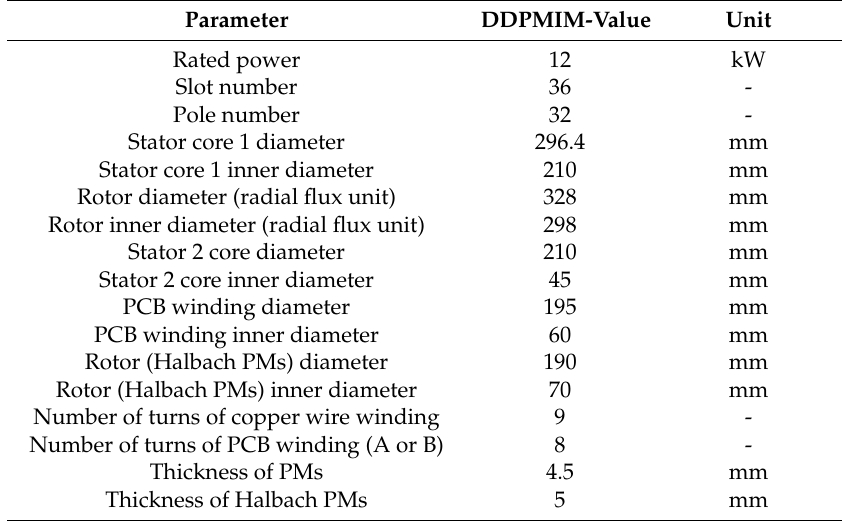
Table 2. Main parameters of the DDPMIM.